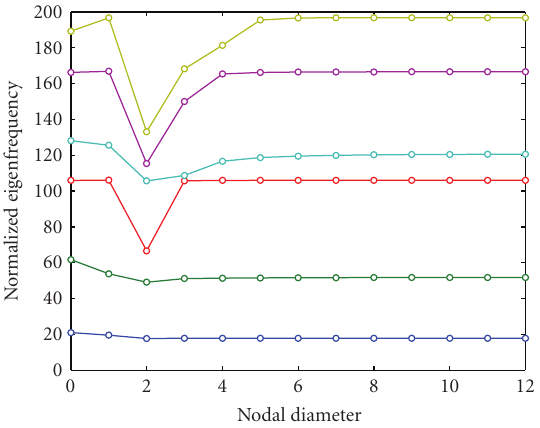
Figure 2: Frequency/nodal diameter